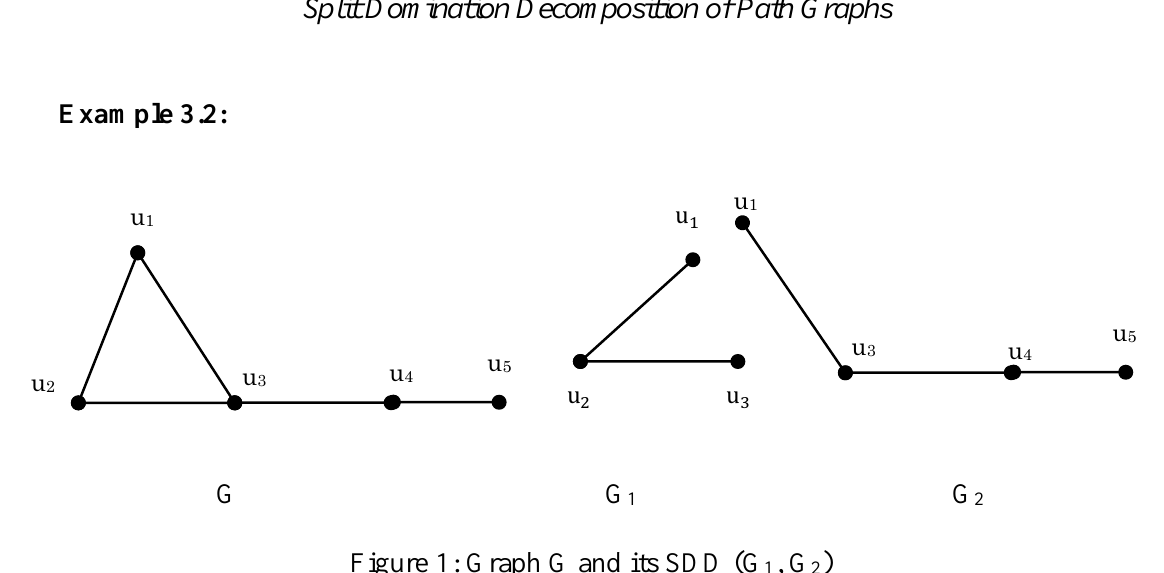
Figure 1: Graph G and its SDD (G